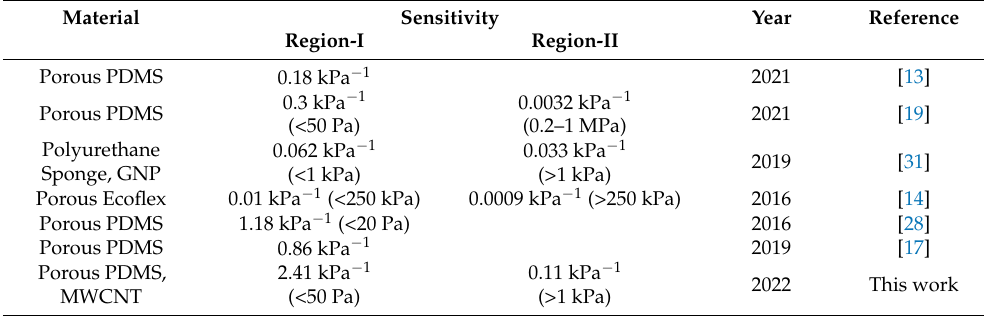
Table 1. Comparison among recent